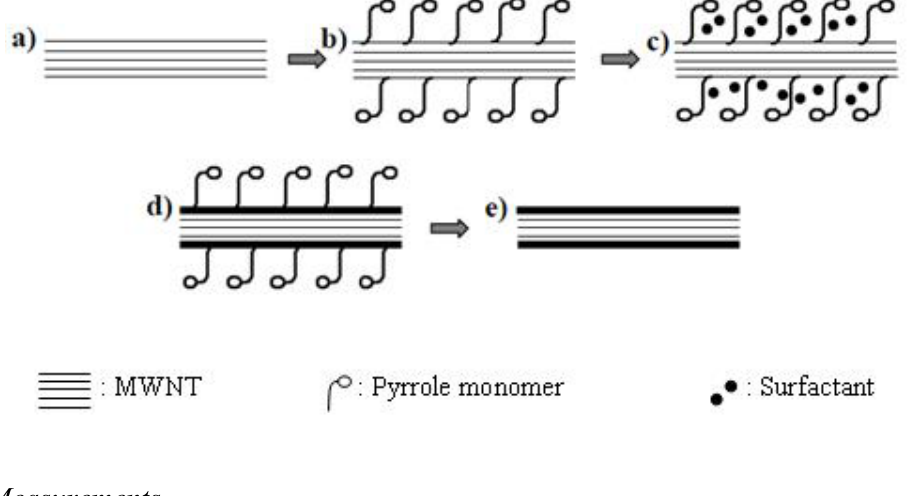
Figure 2. Schematic representation of the formation of the PPy/MWNT nanocomposite in the presence of sodium dodecylbenzensulfonate (SDBS) surfactant. ( a ) MWNT; ( b ) MWNT surrounded by surfactant after sonication; ( c ) pyrrole adsorption on the MWNT surface; ( d ) polymerization of pyrrole on MWNT; ( e ) PPy coated MWNT after washing.